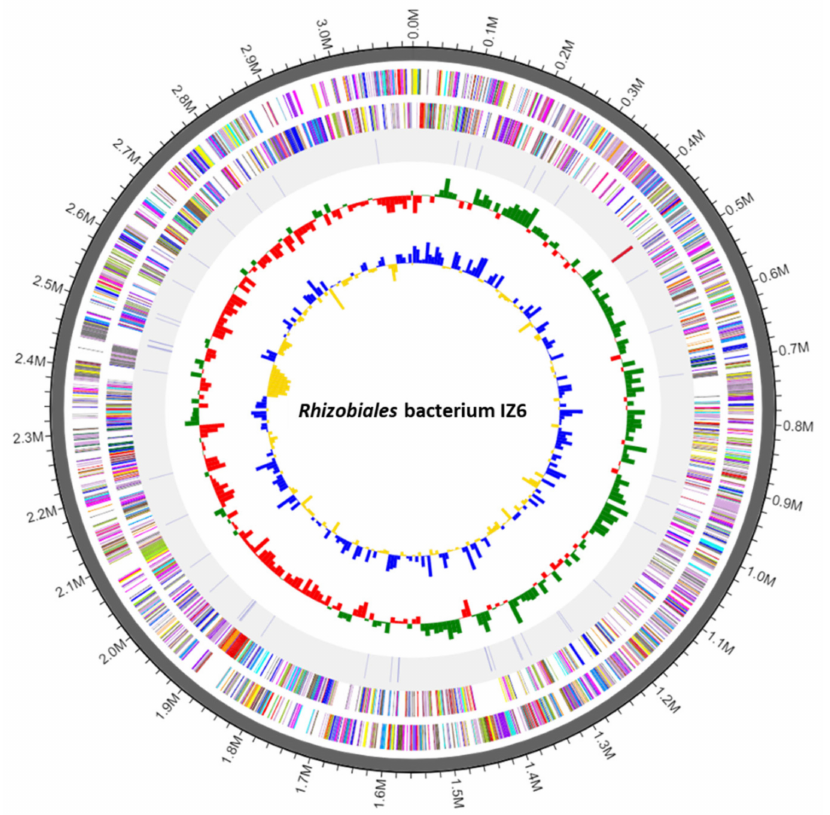
Figure 1. Genomic map of the Rhizobiales bacterium IZ6 chromosome. From outside to center: genes, specifically protein-coding sequences, on the forward strand are colored by clusters of orthologous group (COG) functional categories; genes on the reverse strand; rRNA and tRNA; guanine − cytosine (GC) skew metric (mean GC-skew value was used as a baseline, with higher-than-average values in green and lower-than-average values in red); and GC ratio metric (mean GC ratio was used as a baseline, with higher-than-average values in blue and lower-than-average values in yellow). The full-length 16S rRNA gene sequence (1480 bp) of IZ6, which was retrieved from the genome, showed low sequence identity (96.9%) with the nearest type strain, Flaviflagellibacter deserti SYSU D60017 T , in the order Rhizobiales (class Alphaproteobacteria ), as recently described [41]. Figure 2 shows the phylogenetic placement of IZ6 based on the 16S rRNA gene-based phylogenetic